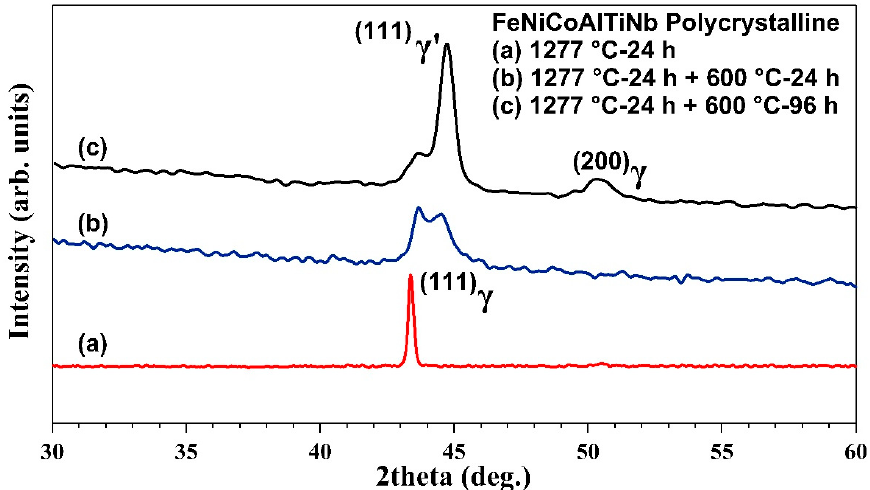
Figure 3. XRD results for FeNiCoAlTiNb alloys for different aging conditions.